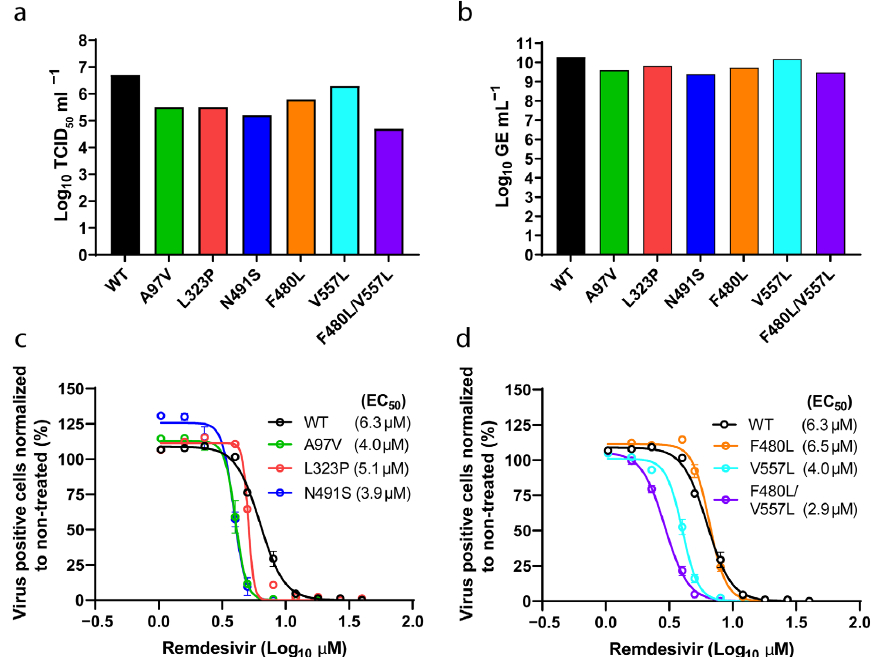
Figure 4. Analysis of SARS-CoV-2 nsp12 polymerase mutants. ( a ) Peak infectivity titers (TCID 50 /mL) of second passage SARS-CoV-2 viruses with specified nsp12 substitutions and of the parental wild- type clone (WT). ( b ) SARS-CoV-2 RNA titers of the same samples measured by E-sequence specific RT-qPCR. ( c , d ) Concentration–response curves of infections from the constructs depicted in ( a ) and ( b ) treated with different remdesivir concentrations. The dots represent the mean, and standard errors of the mean are shown as lines. EC 50 values (μM) inferred from the regression analysis are shown in parenthesis for each construct. For some data points the differences are too small to plot error bars.